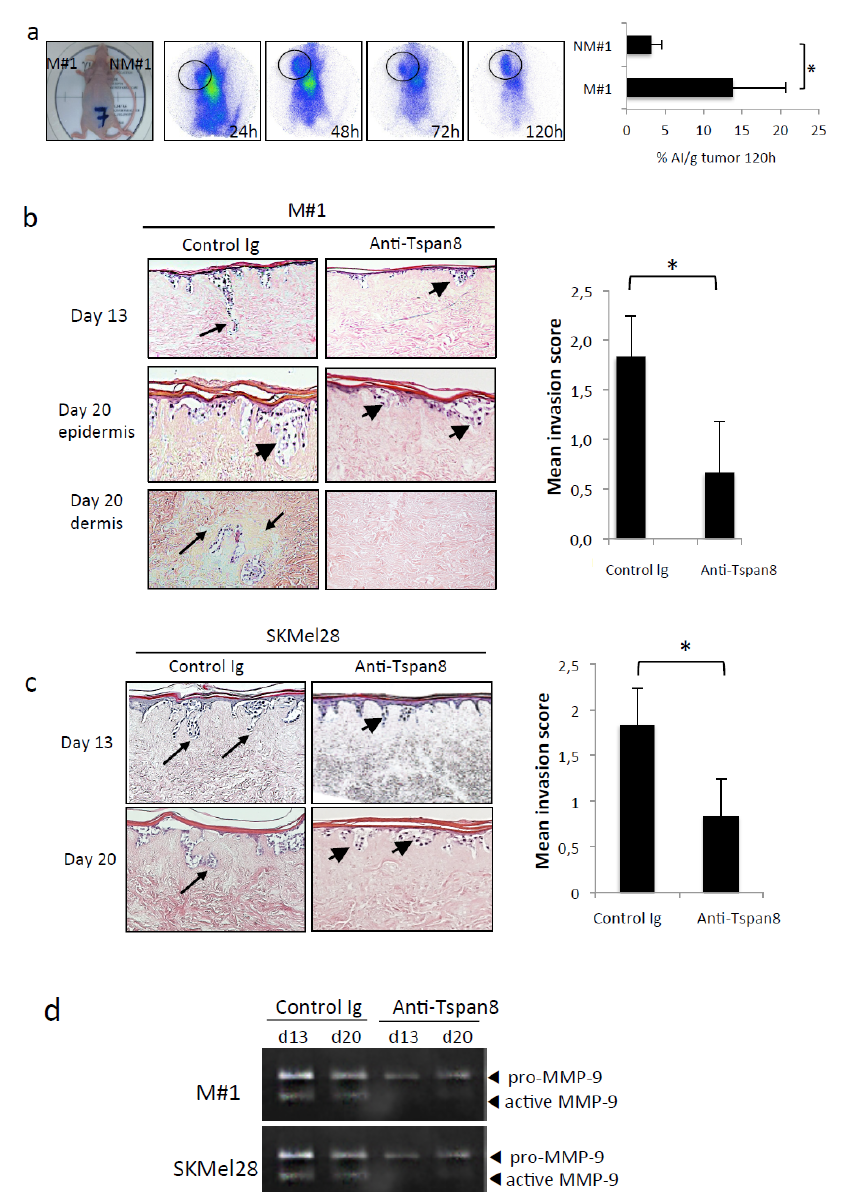
Figure 7. Anti-Tspan8 mAb efficiently targets Tspan8-positive melanoma cells in vivo and reduces MMP-9 activation and dermal invasion. ( a ) Mice with Tspan8 + (left side) and Tspan8- xenografts (right side) were injected (i.v.) with 3.7 MBq of [111In] DOTA-mAb and imaged with a γ -camera at 24 h, 48 h, 72 h and 120 h post-injection. Whole body SPECT / CT images of mice demonstrate specific accumulation of [111In] DOTA-mAb in Tspan8 + tumors (surrounded) but significantly lower in Tspan8- tumors. Tumors were collected 120 h after injection and the radioactivity was measured by γ -counting of each sample. The graph represents the % of injected activity per gram of tissue (%IA / g, n = 4). ( b ) Representative H&E staining of SR with metastatic M#1 cells treated with control IgG or 0.5 µ M Ts29 at 13 and 20 days. The graph depicts the invasion scores (see Materials and Methods). ( c ) Representative H&E staining of SR with SKMel28 cells treated with control IgG or 15 µ g / mL Ts29 at 15 and 21 days. Arrow heads: melanoma cell clusters close to DEJ; arrows, melanoma cells invading the dermis (Scale bars: 10 µ m). Data representative of 6 independent experiments. Graph depicts results of invasion score analysis. ( d ) Serum-free conditioned media collected from SR integrating M#1 and SKMel-28 cells were analyzed by gelatin zymography at 21 days (representative zymogram of 3 independent experiments). * p <